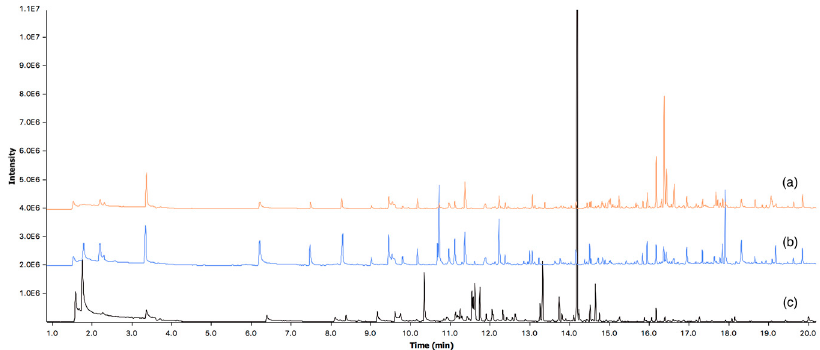
Figure 4. Overlaid total ion chromatograms showing recovered headspace solid-phase microextraction (HS-SPME) volatiles from ( a ) Female participant’s skin (F1); ( b ) Male participant’s skin (M1); and ( c ) Labskin.